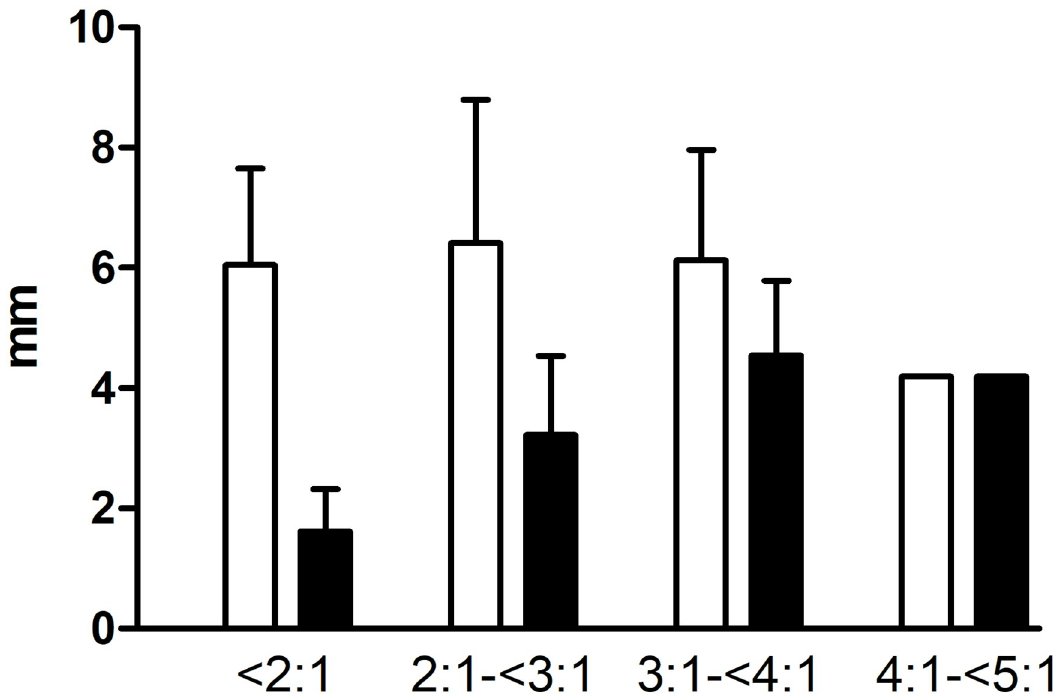
Fig 2. 100 abdominal midline closure measurements in dogs categorized by SL:WL ratios < 2:1, 2:1- < 3:1, 3:1- < 4:1, and 4:1- < 5:1 analyzed for the mean SI ± SD and mean TB ± SD.